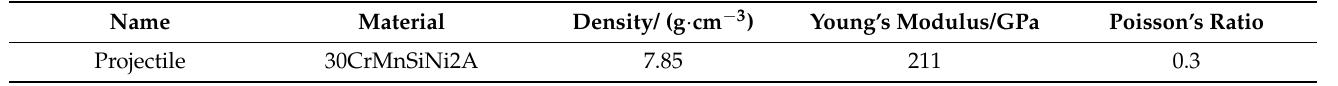
Table 5. Main parameters of projectile